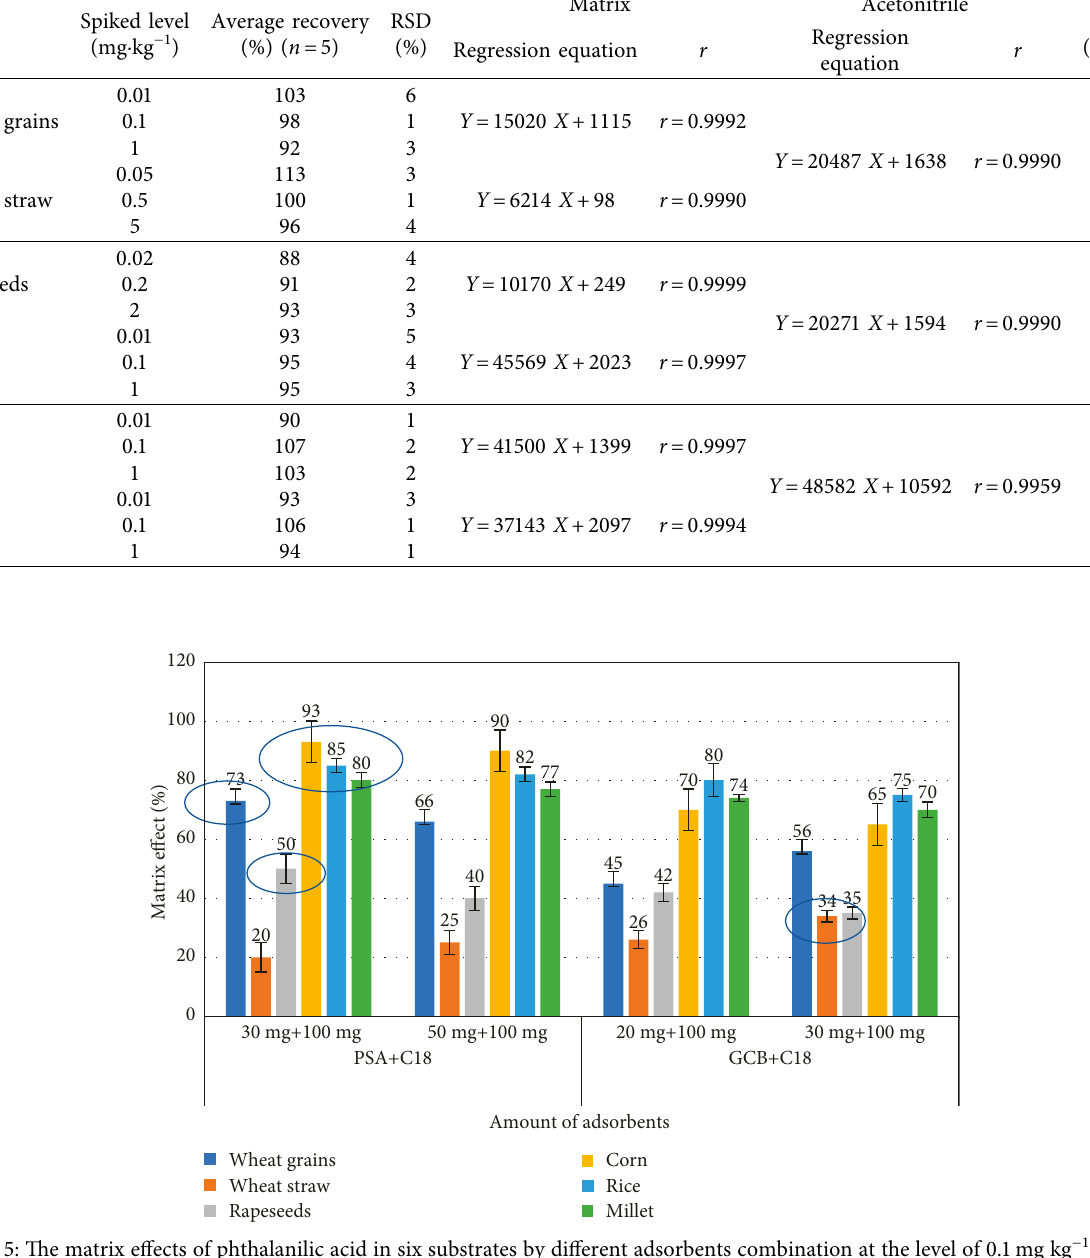
Table 2: Performance characteristics of the method for phthalanilic acid in cereals, wheat straw, and rapeseeds. Crops